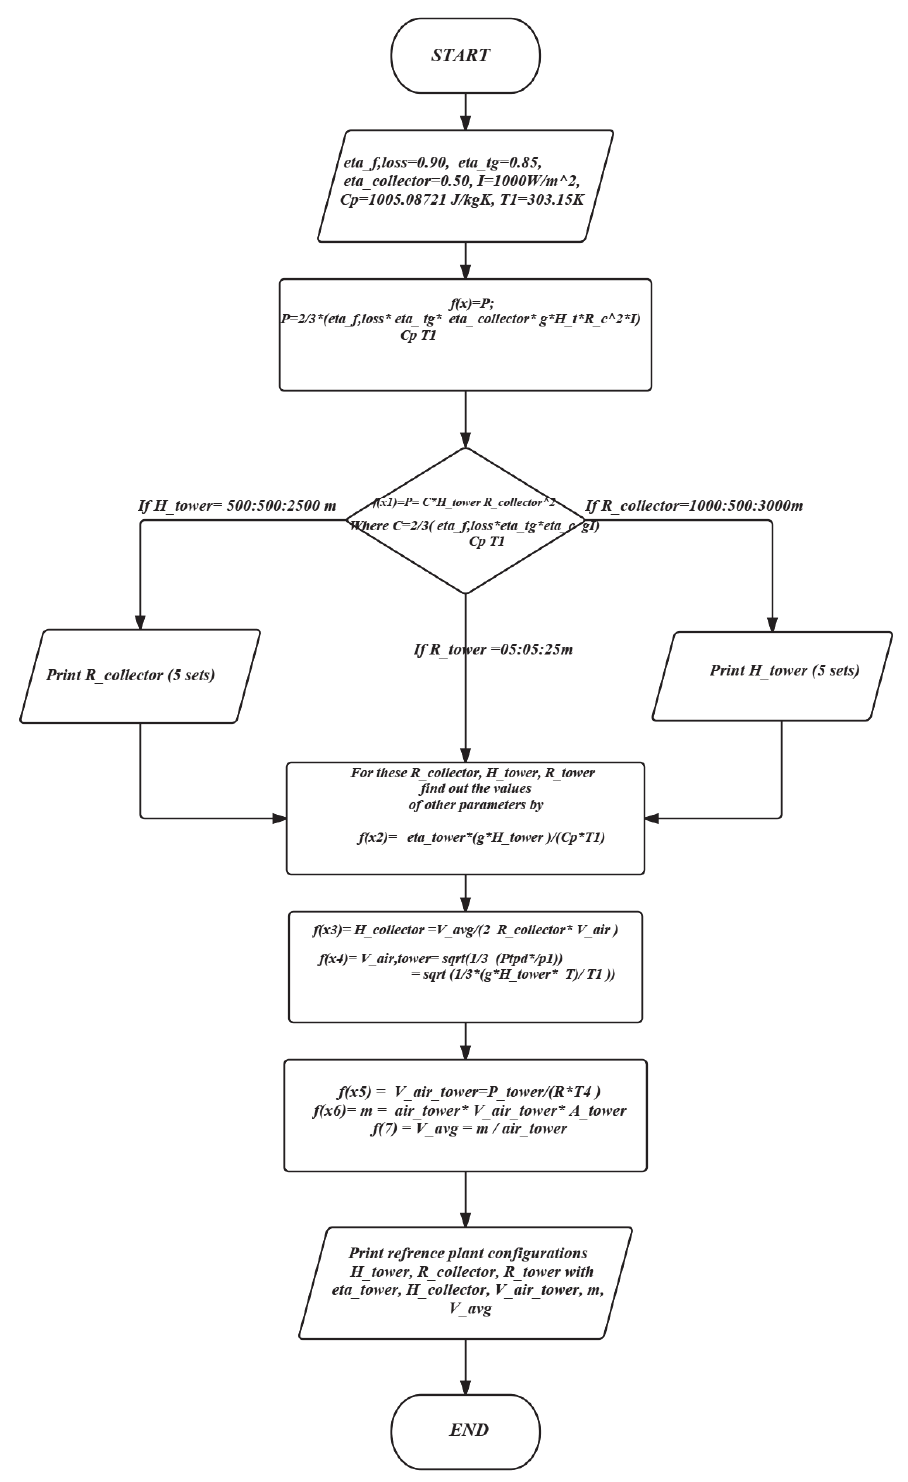
Figure 7. Flow chart of program developed for calculating the specification of SUTPP.